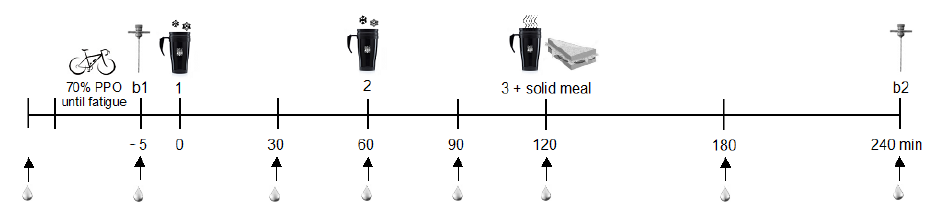
Figure 2. Experimental session time course. b1: first biopsy; b2: second biopsy; PPO: peak power output; 1: first beverage dose; 2: second beverage dose; 3: third beverage dose.